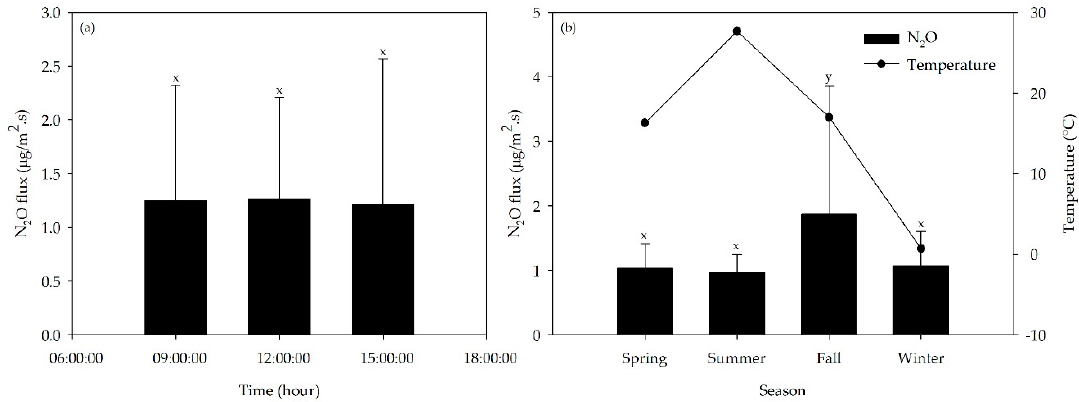
Figure 7. Average N 2 O flux from litter by ( a ) time and ( b ) season (error bars represent the standard deviation of the average). Flux means with the same letter are not significantly different ( p > 0.05) .